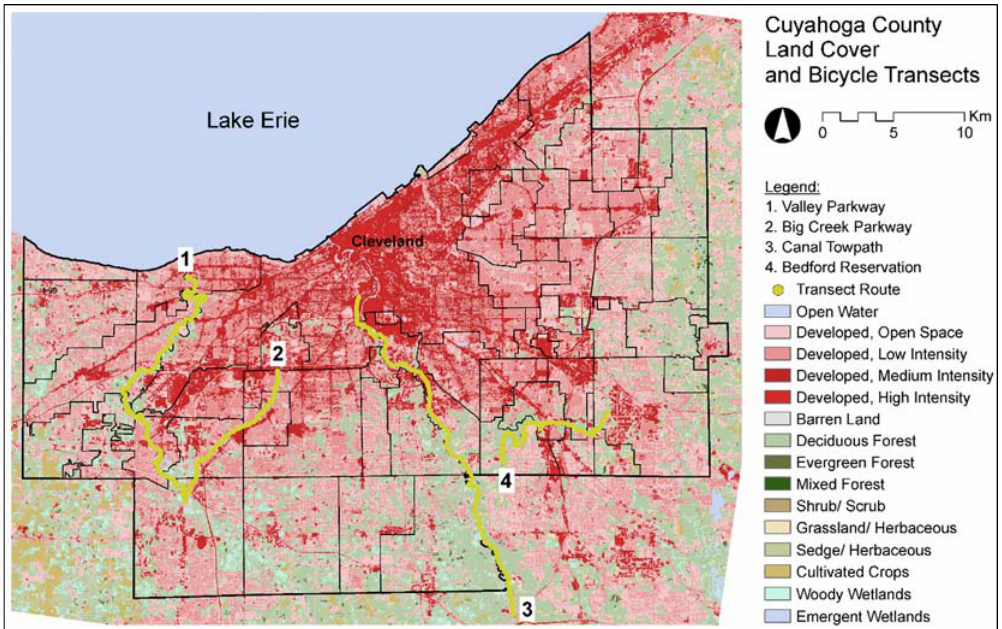
Figure 2. Map of transect routes. Data sources: Cuyahoga County Geographical Information Systems Department (2012), U.S. Census Bureau (2010), National Land Cover Database (2006).